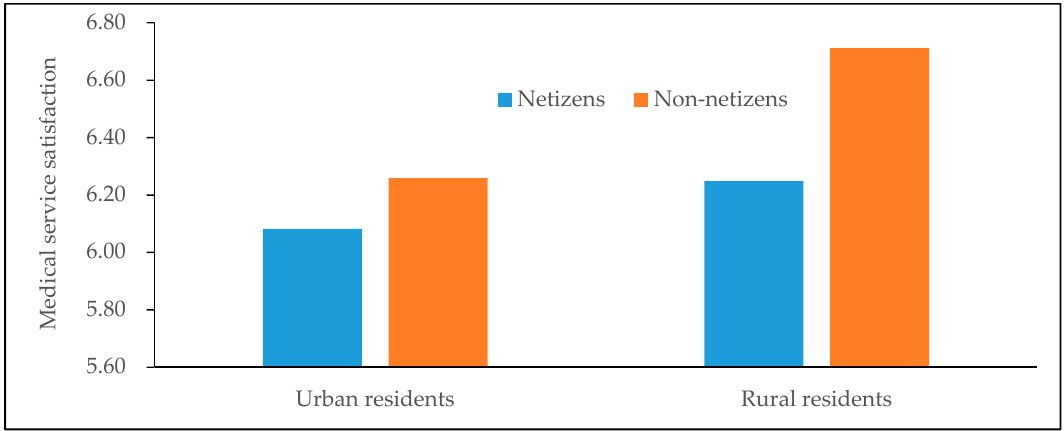
Figure 2. Di ff erences in medical service satisfaction between netizens and non-netizens (by urban-rural). Data are from the Chinese Social Survey [51] for 2013, 2015 and